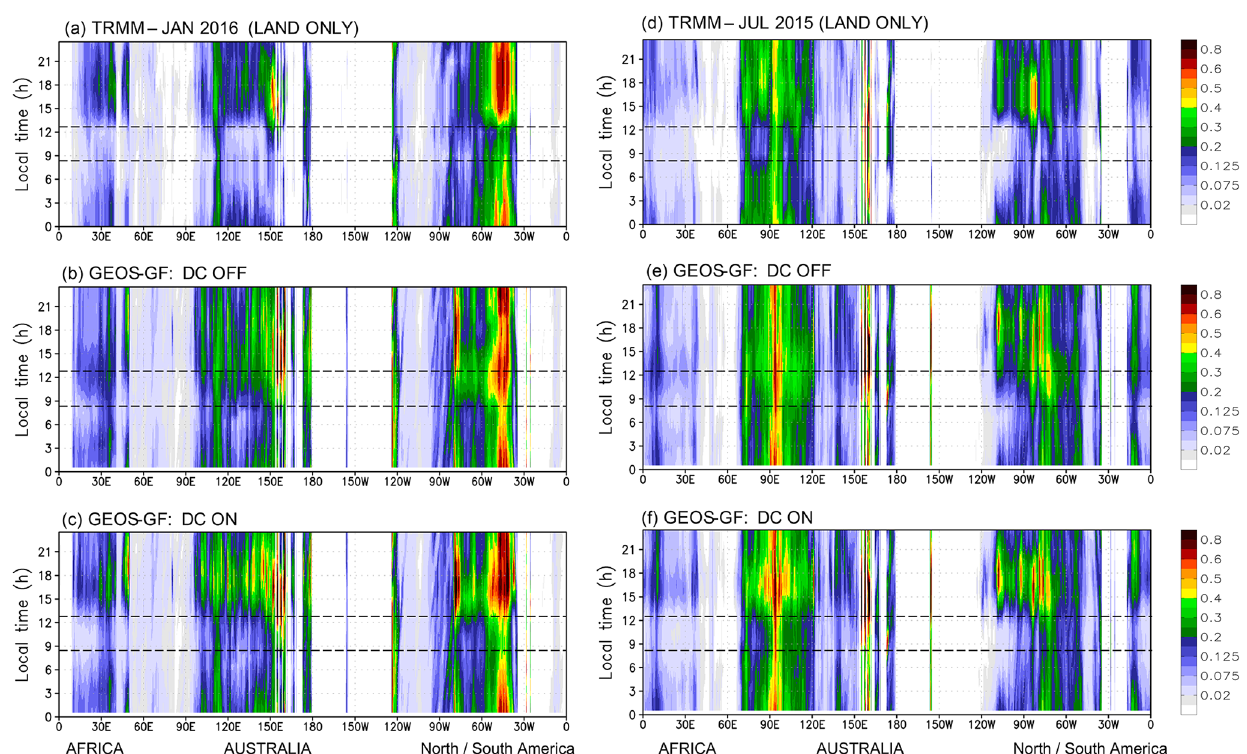
Figure 13. Global Hovmöller diagram (average over latitudes 40 ◦ S to 40 ◦ N) of the diurnal cycle of precipitation (mmh − 1 ) from remote- sensing-derived observations (TRMM, a, d ) and the NASA GEOS GCM applying the GF scheme without the diurnal cycle closure ( b, e , DC OFF) and with ( c, f , DC ON). The results account for precipitation only over land regions and are monthly means for January 2016 (a, b, c) and July 2015 (d, e, f) ,